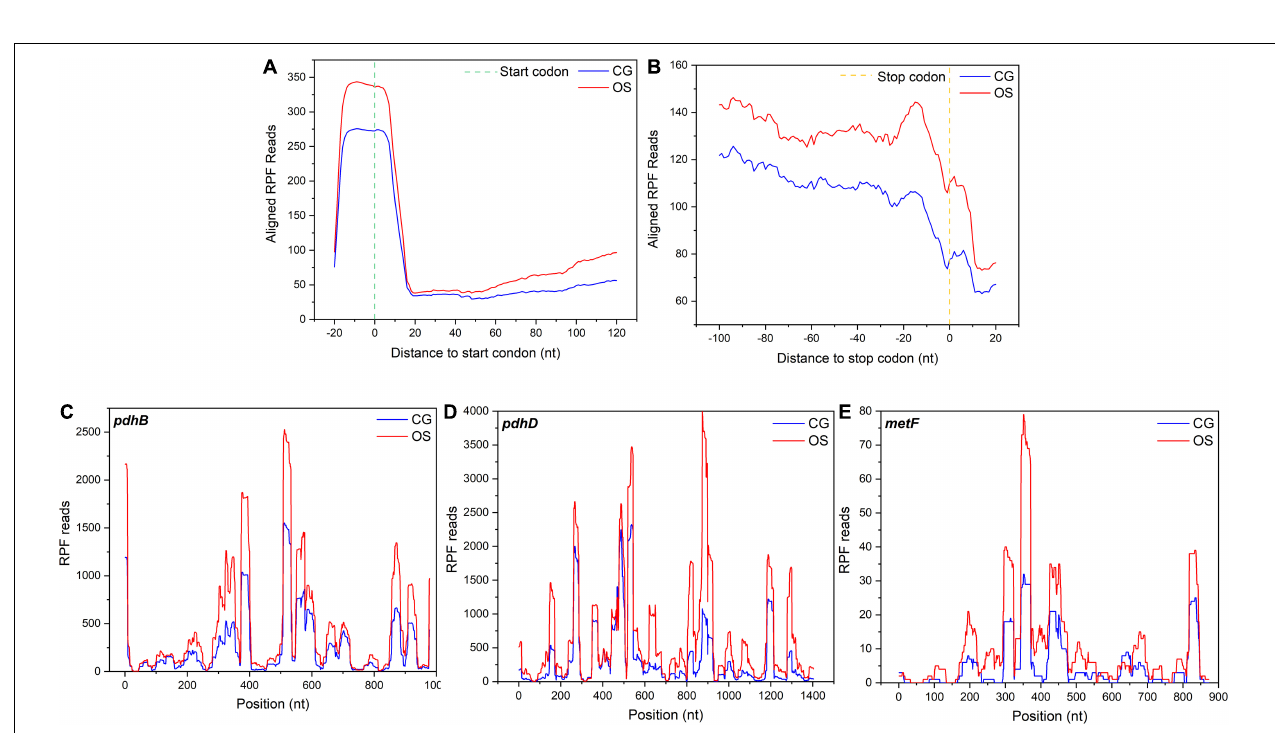
FIGURE 6 | The mapped reads of DEGs with regulated TE and transcript under osmotic stress. (A–H) The DEGs were rpmG, rpsC, rpsD, rpsT, lspA, yheI, ecfT , and dltC , respectively.